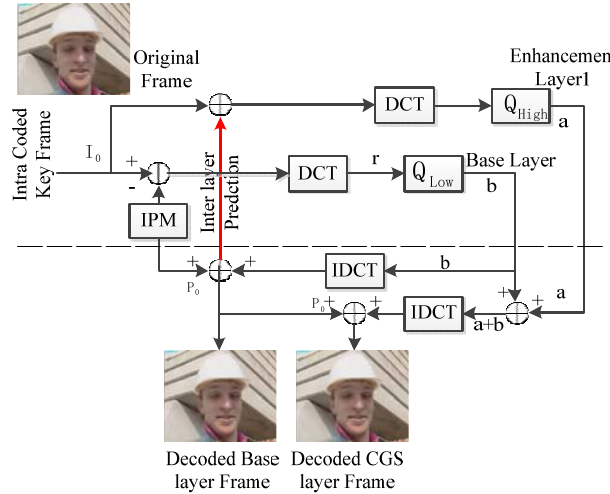
Fig.2. Quality scalability coding in